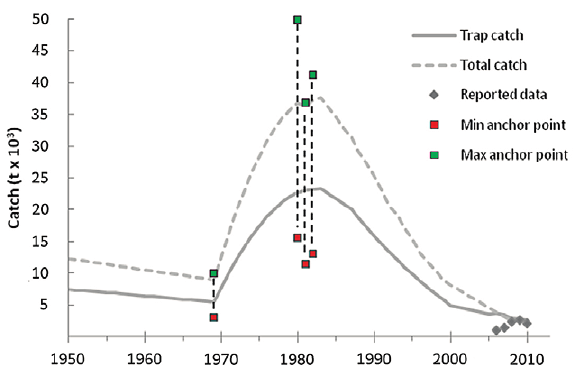
Fig. 5. – Estimated catch of demersal species form the trap fishery plotted against various landing sites,